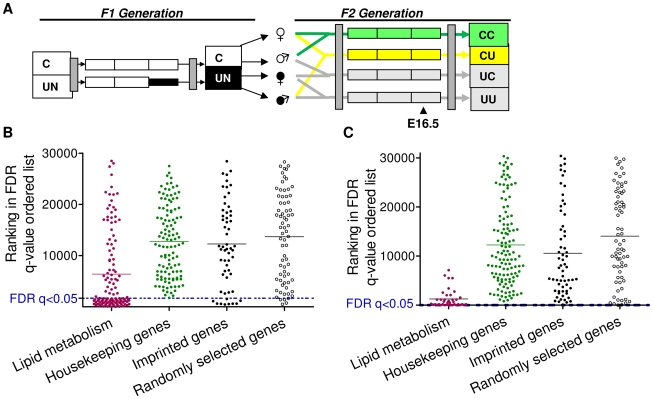
Characterisation of the F2 CU hepatic and placental transcriptome.(A) Schematic of the F2 generation, the transcriptome of the CU and CC F2 crosses was assessed at E16.5. (B) Distribution of the ranked difference in gene expression in CU E16.5 liver according to FDR q-value. A list of genes comprising a network involved in lipid metabolism, identified as enriched in CU liver using IPA software was used as a positive control. Imprinted genes most closely resemble randomly selected genes. (C) Distribution of genes differentially expressed in CU E16.5 placenta according to FDR q-value. A list of genes comprising a network involved in lipid metabolism, identified as enriched in CU placenta using IPA software was used as a positive control. Imprinted genes most closely resemble randomly selected genes.